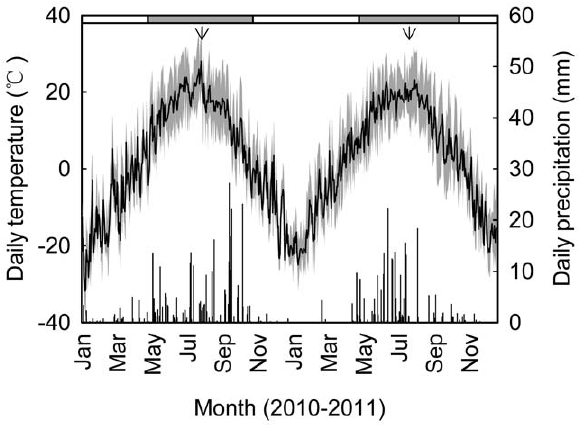
Figure 2. Daily maximum, minimum and mean air temperature (lines) and precipitation (bars) at the study site in 2010 and 2011. The filled rectangles on the top of figure indicate the growing season (May to October) and the open rectangles for the non-growing season (November to April). The arrows mark the timing of field campaigns when the gas exchange measurements were